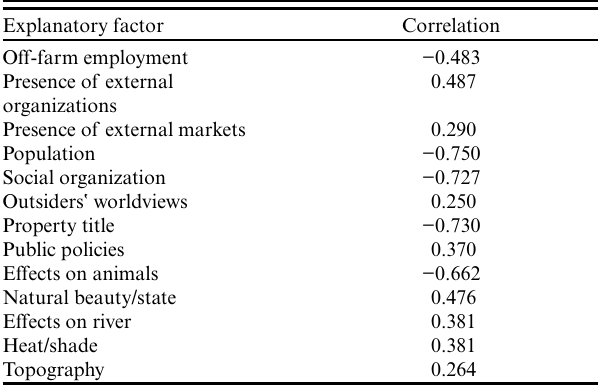
Table 5 . Correlations of influences on land uses with discriminant functions.